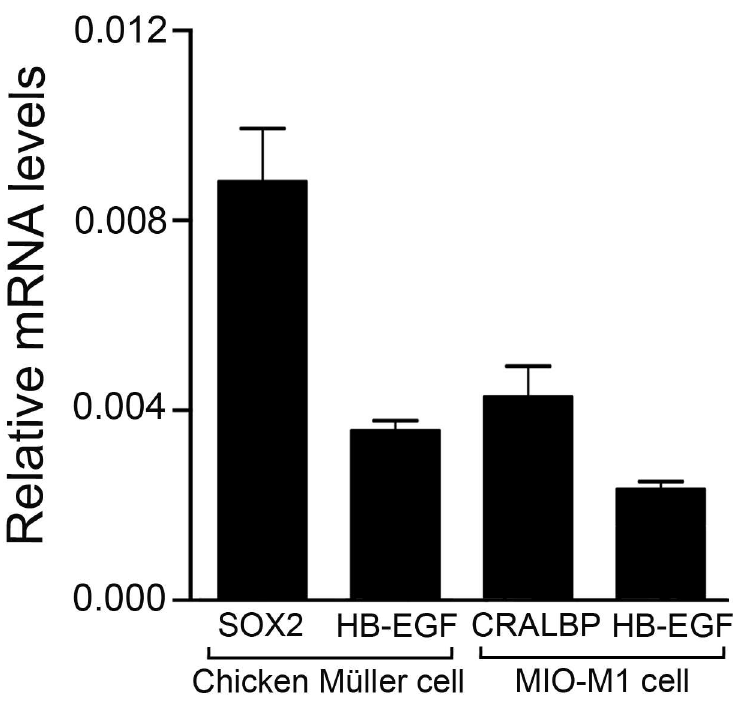
Fig 10. Expression of HB-EGF in chicken Mu¨ller cells and in human MIO-M1 cell line. QRT-PCR analysisof heparinbindingepidermal growth factor (HB-EGF), transcription factor SOX2 and cellular retinaldehyde-bindingprotein (CRALBP) mRNA levels in primary chicken Mu¨ller cell and in human MIO-M1 cell cultures. SOX2 and CRALBP were includedas expressionreferences known to be expressedin Mu¨ller cells. Bar graph showingthe relative mRNA levels in relationto β -actin mRNA levels. Bar graph is mean ± SEM, n >